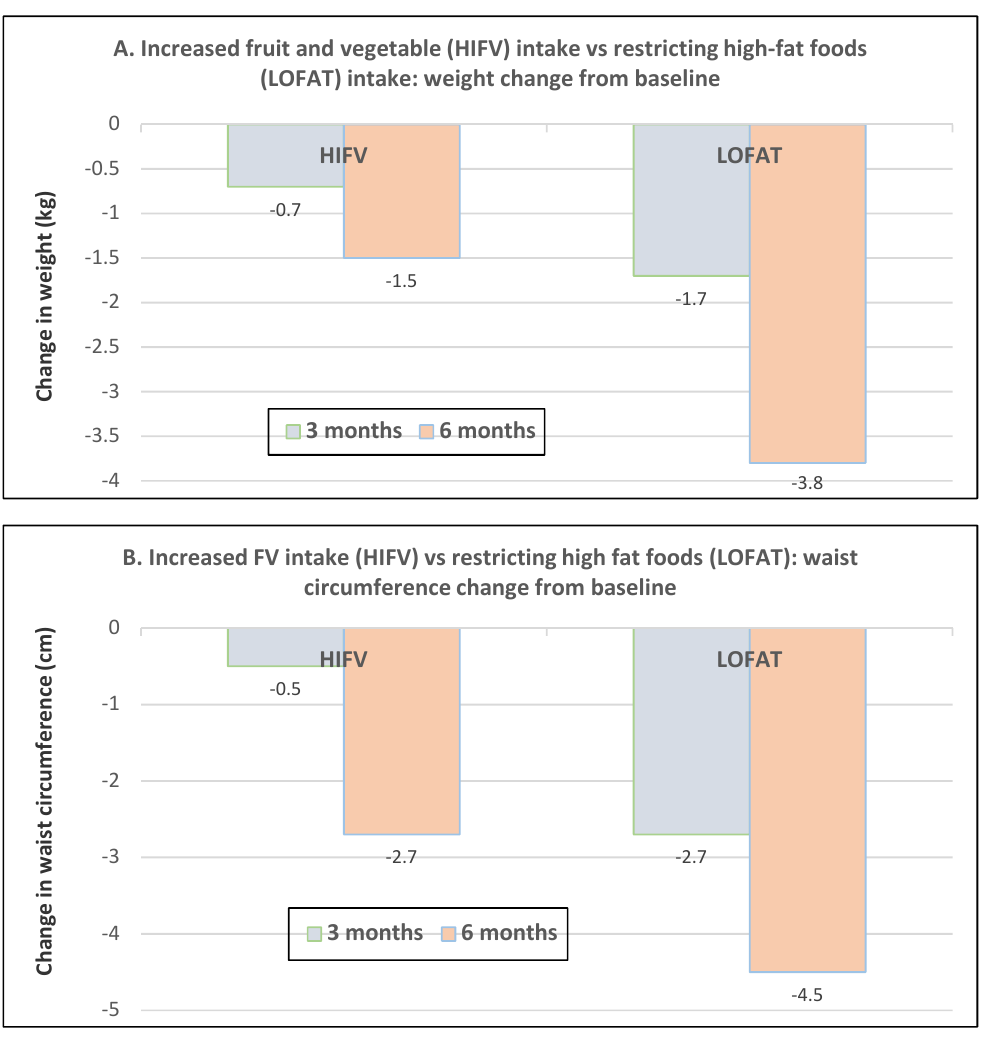
Figure 16. Messaging to encourage increased fruit and vegetable (HIFV) intake vs. restricting intake of high-fat foods (LOFAT) in overweight or obese postmenopausal women: ( A ) weight change (LOFAT group p < 0.001 at both 3 and 6 months vs. baseline; HIFV p = 0.1829 at three months and p = 0.0004 at six months vs. baseline) and ( B ) waist circumference change (both diets p < 0.05 at six months vs. baseline) [52].